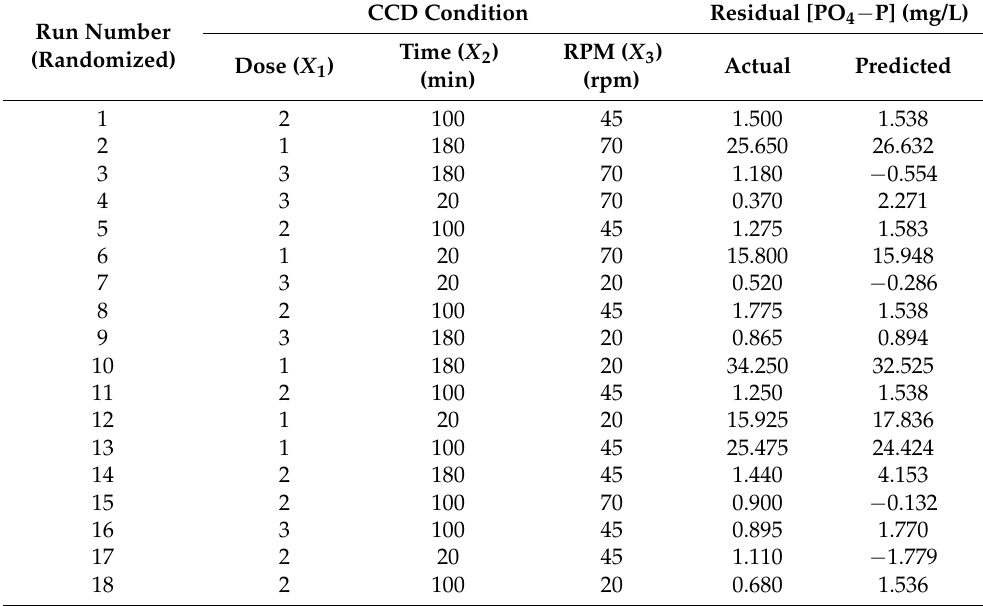
Table 2. The experimental design and results for the optimization study using